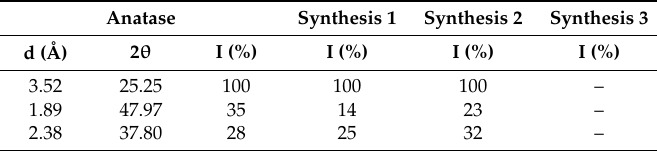
Table 5. Theoretical and experimental values for diffraction analysis. Anatase Synthesis